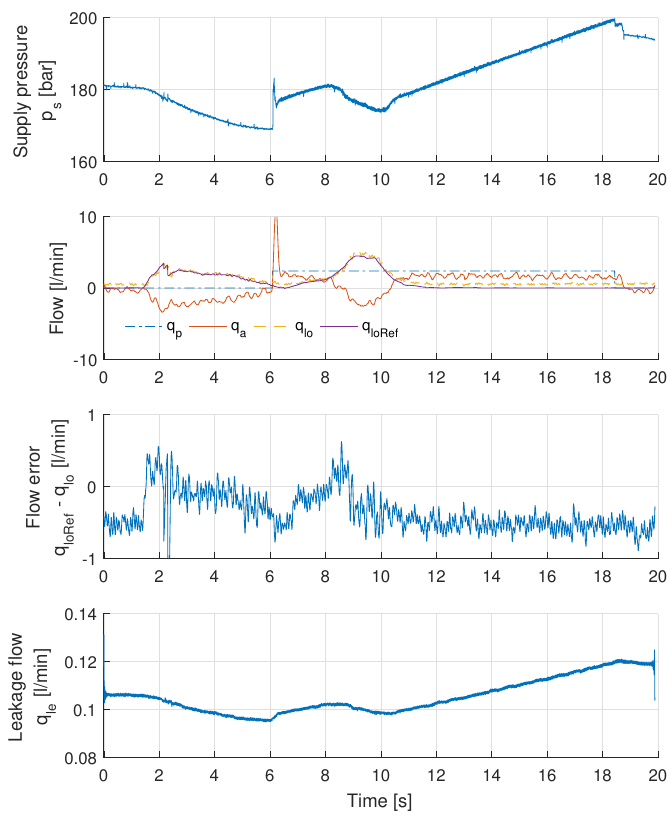
Figure 12. Measured flows and pressures from the experimental setup when operating under nominal conditions. One hundred bar pre-charge pressure and high external fluid leakage flow are